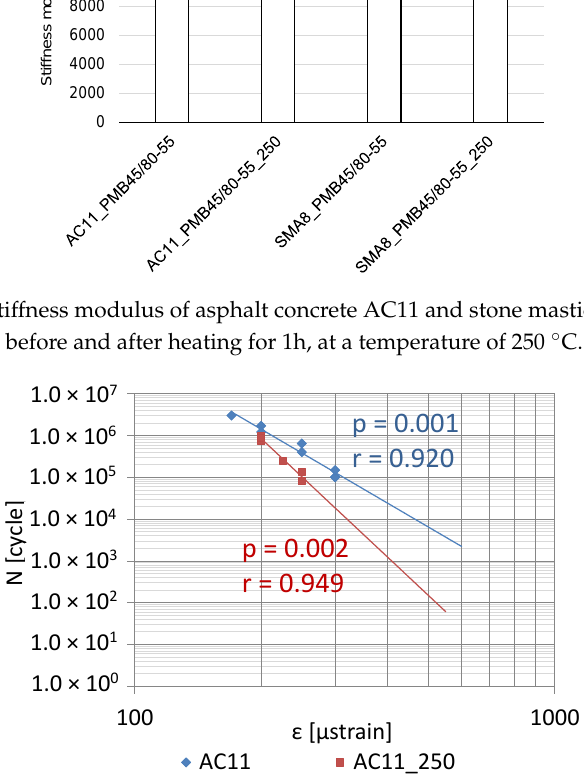
Figure 14. Fatigue life of AC11 mixture with PMB45/80-55, before and after heating at a temperature of 250 °C (1 h).